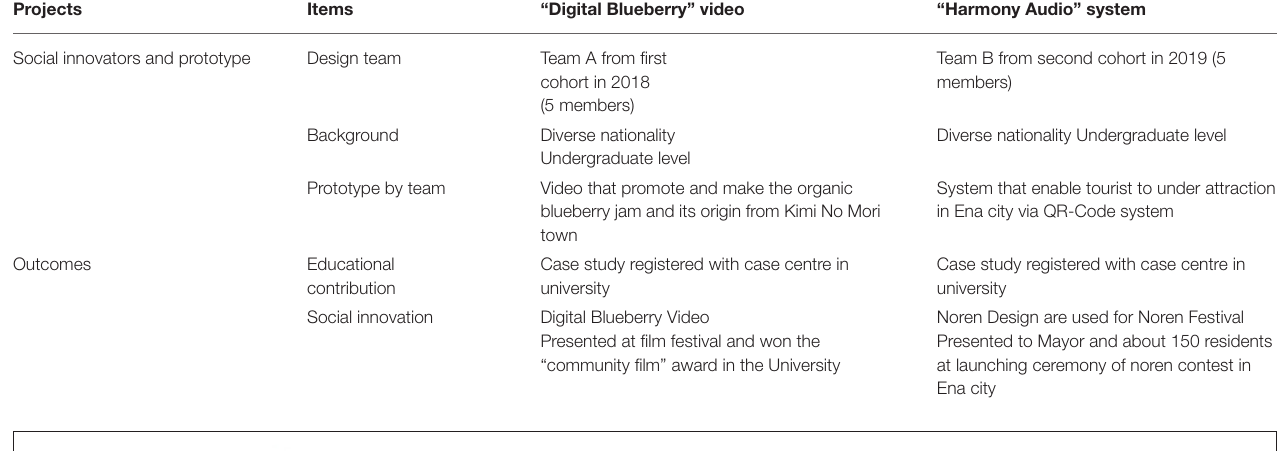
TABLE 4 | Social innovation through design thinking.